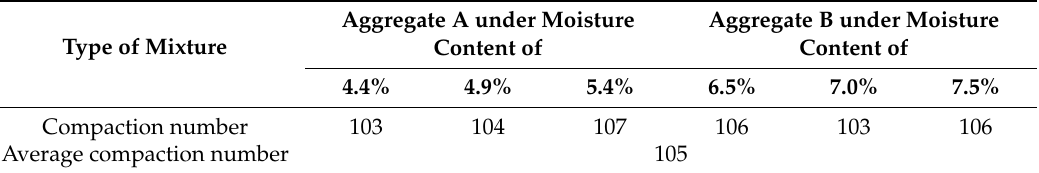
Table 4. Locking points under different moisture contents.